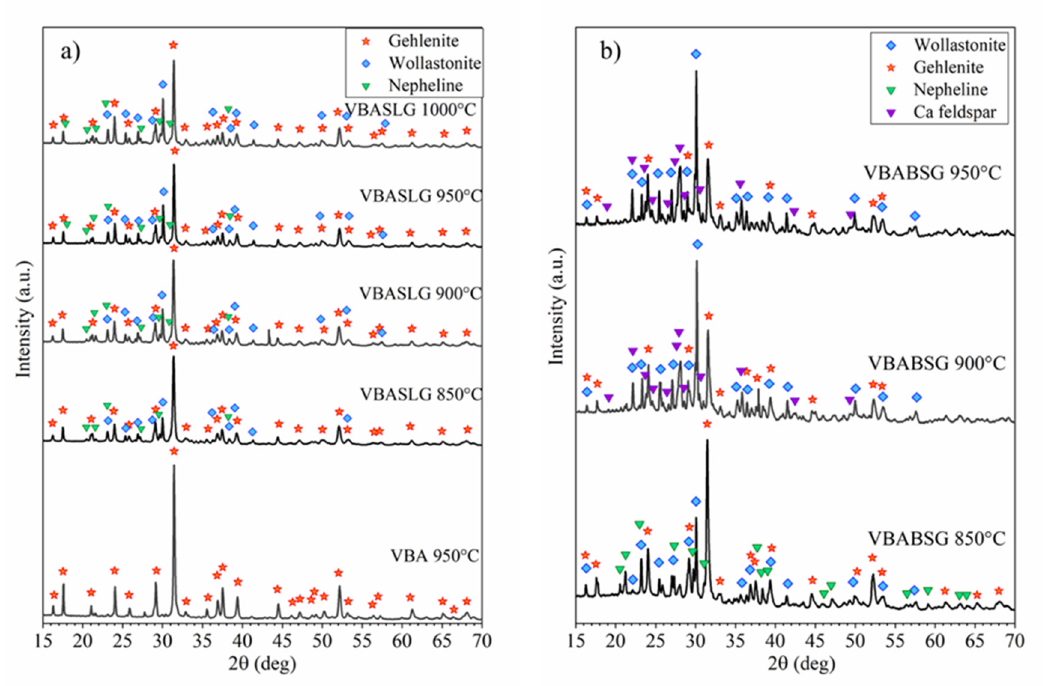
Figure 4. Mineralogical analysis of ( a ) VBA–SLG glass-ceramic foams and ( b ) VBA–BSG glass-ceramic foams.